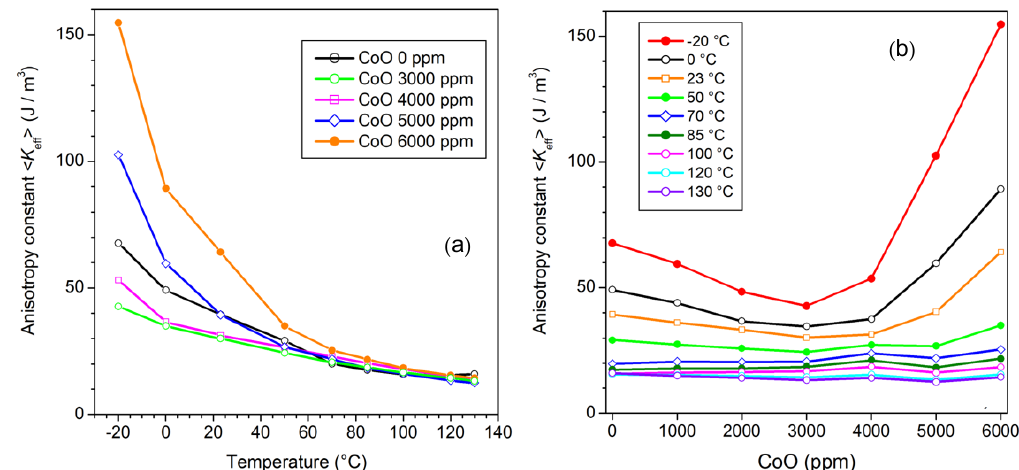
Figure 12. The effective anisotropy < K eff >, calculated from knowledge of μ rot,DC , exhibits the slowest variation with temperature ( a ) after addition of 3000–4000 ppm CoO ( b ). (Adapted from Ref. [42]).